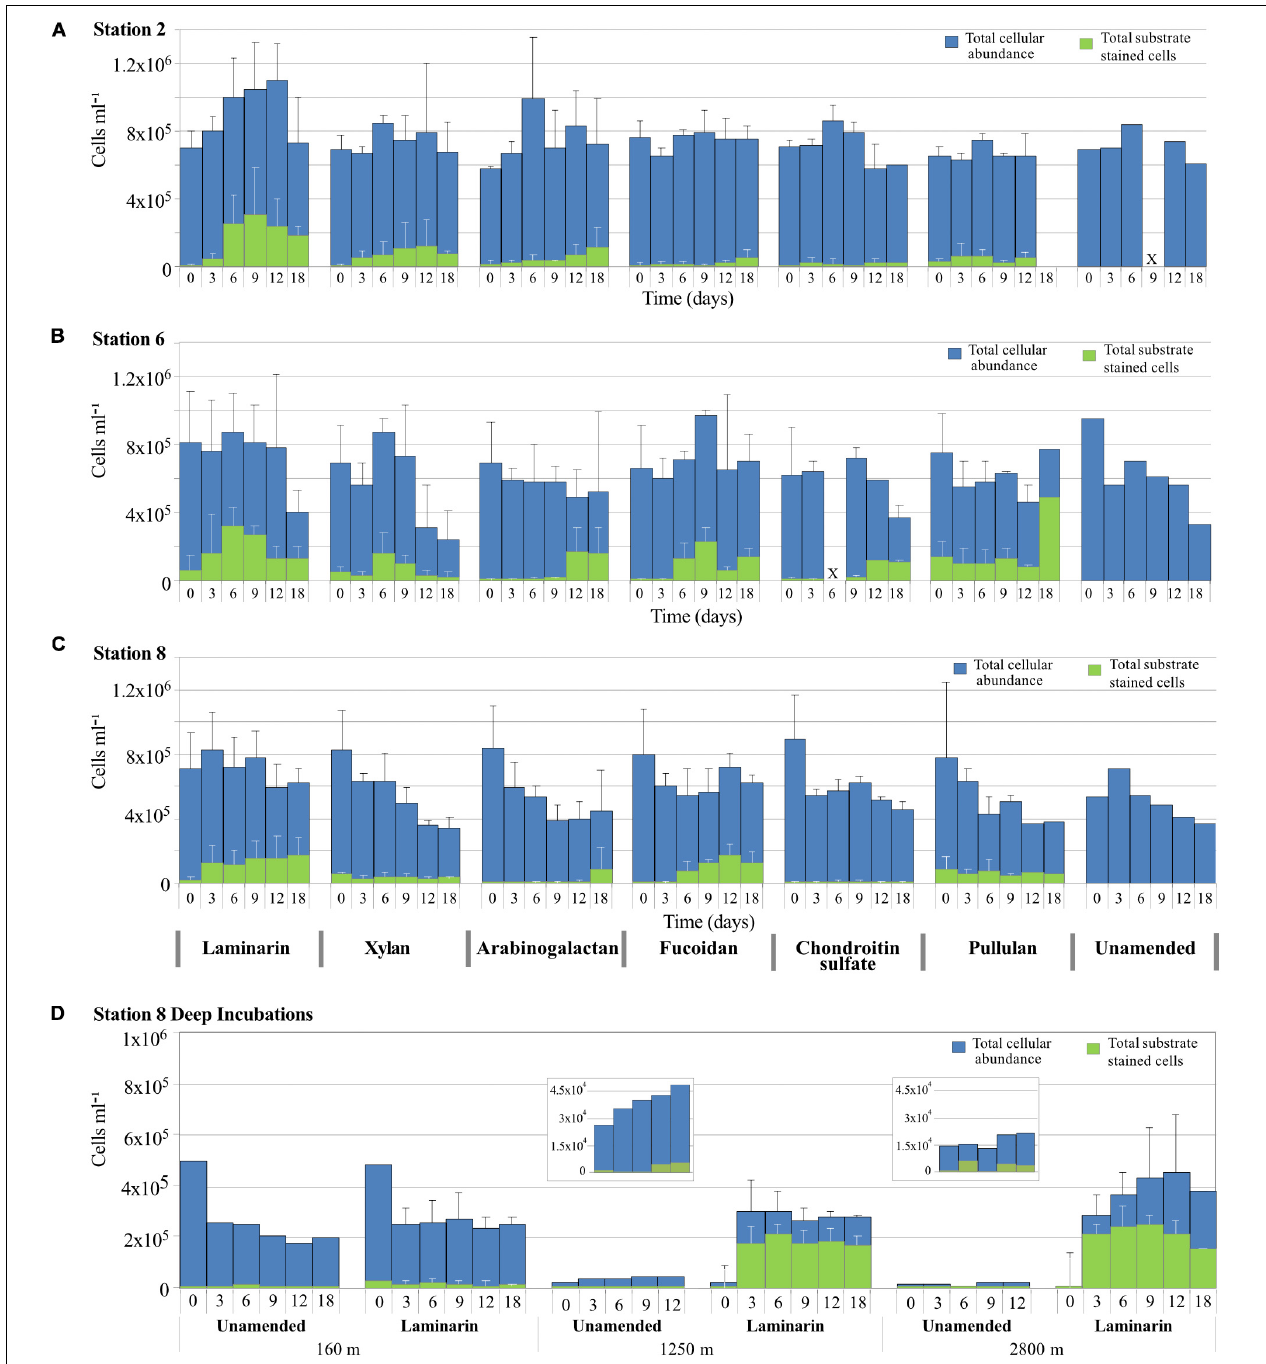
FIGURE 3 | Total cell counts (DAPI staining; shown in blue) and the number of cells showing selfish staining (staining with FLA-PS; shown in green) over time for incubations with different polysaccharides, plus the no-amendment incubation at (A) Stn. 2, (B) Stn. 6, (C) Stn. 8, and (D) depths of 160, 1,250, and 2,800 m at Stn. 8. Error bars show standard deviation between total cell counts from triplicate